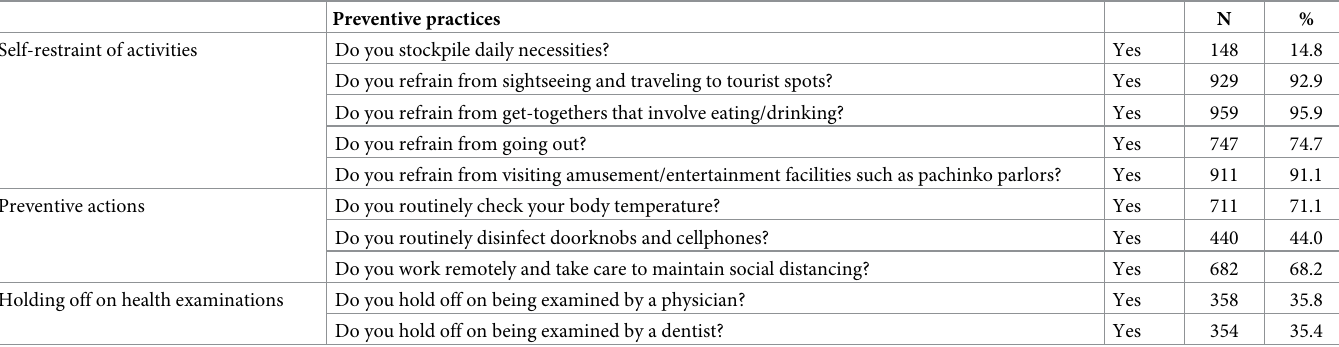
Table 4. Preventive practices at stage of COVID-19 third-wave. Preventive practices